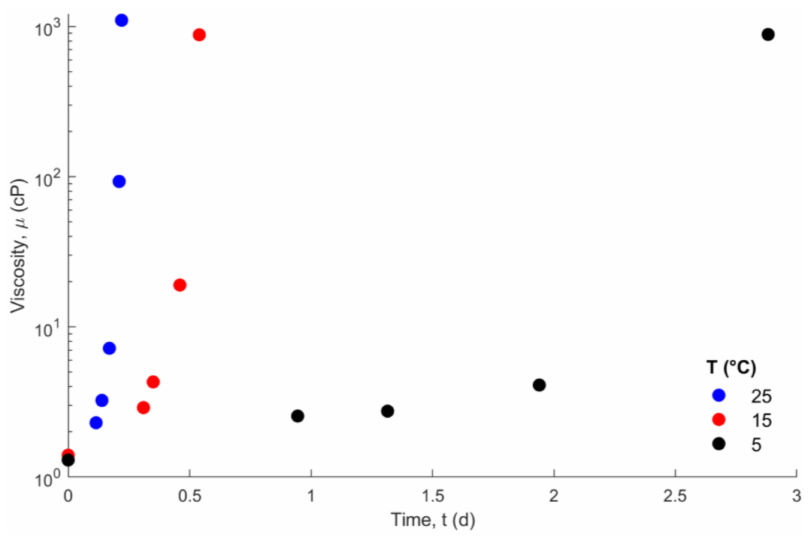
Figure 2. Viscosity against time for a 10% CS solution (NaCl normality = 0.1 N, pH = 6.0): effects of temperature (mod. from